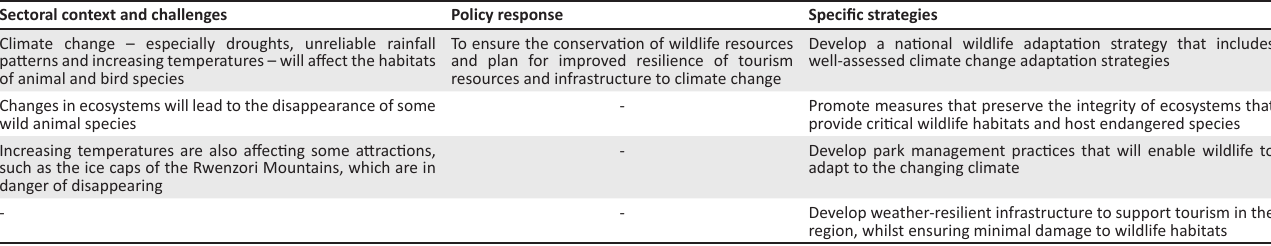
TABLE 5: Uganda National Climate Change Policy and wildlife management. Sectoral context and